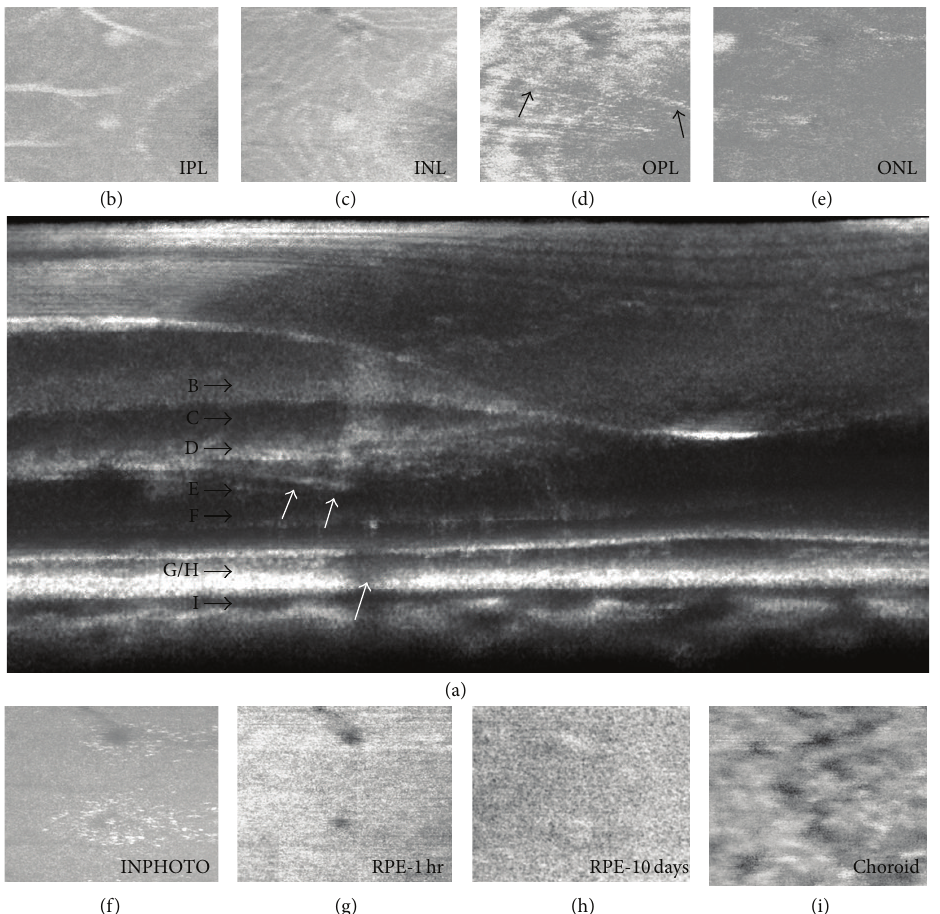
Figure 10: OCT B-scan and en face fly-through of subject S6 retina after receiving 413 nm (240–1,183 J/cm 2 ) exposures 1 hour (a)–(g), (i) and 10 days later